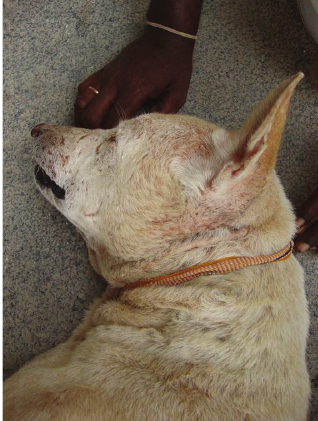
Figure 2: Dog with chronic generalized dermatitis (Case 2).